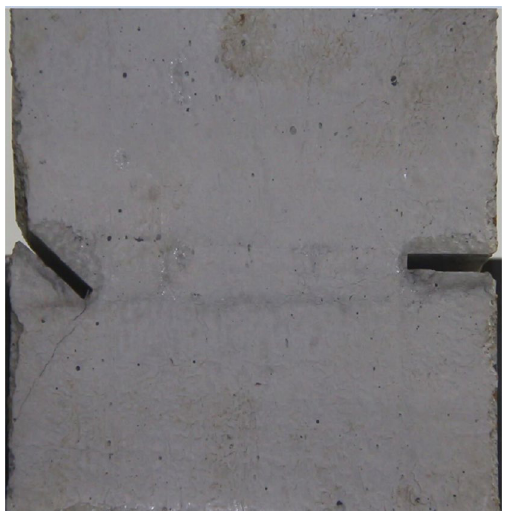
Figure 8. Photograph of a specimen showing of tensile wing crack appearing.